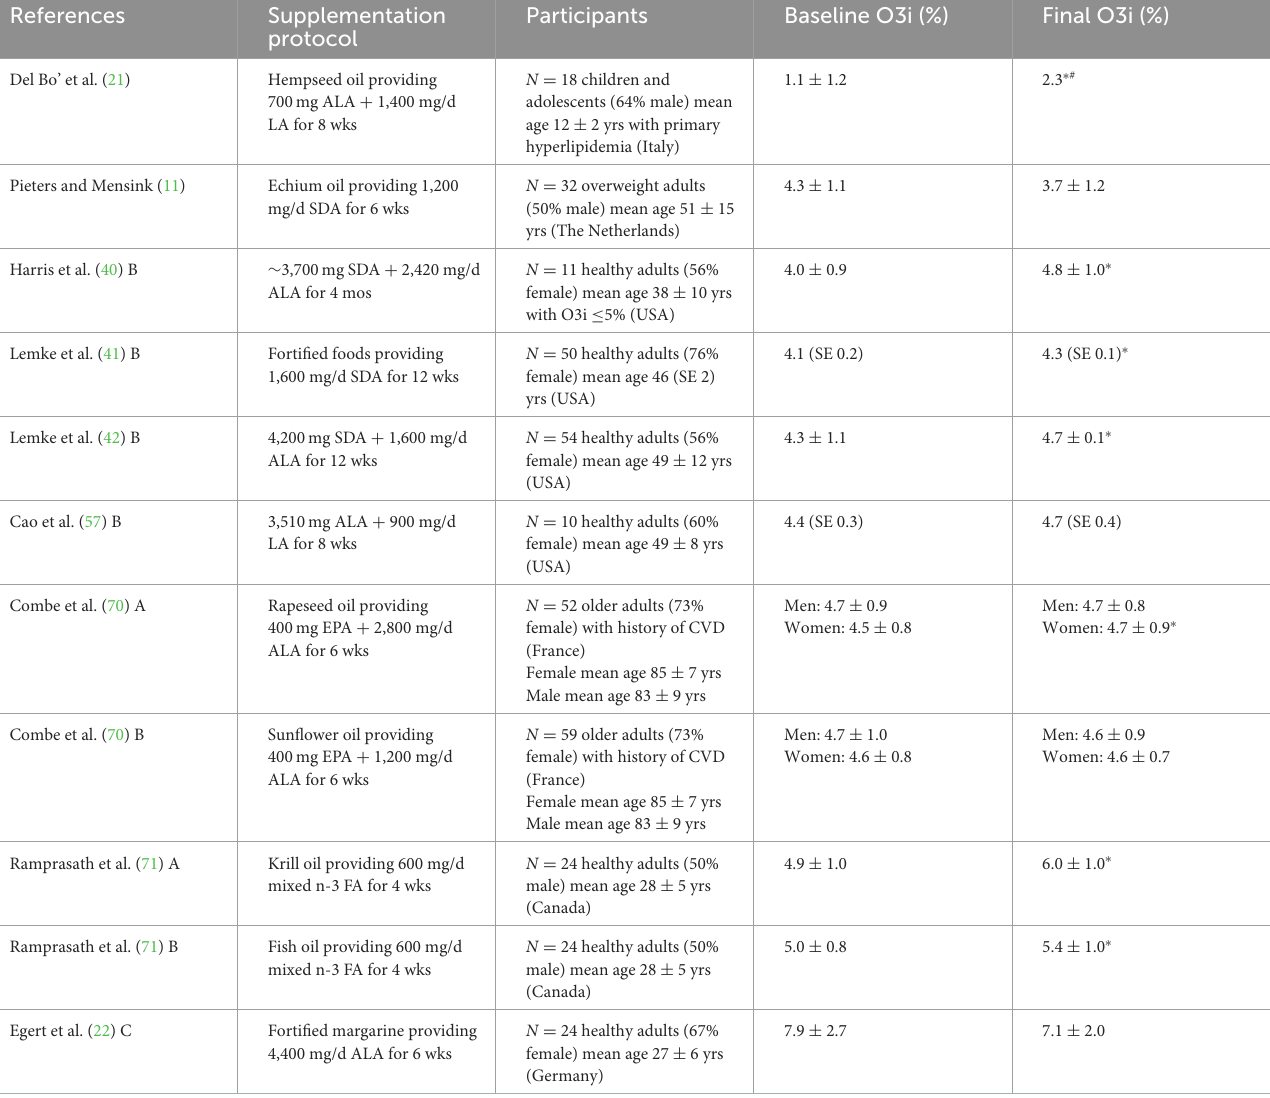
TABLE 4 Other omega-3 fatty acid (n-3 FA) supplementation protocols and omega-3 index